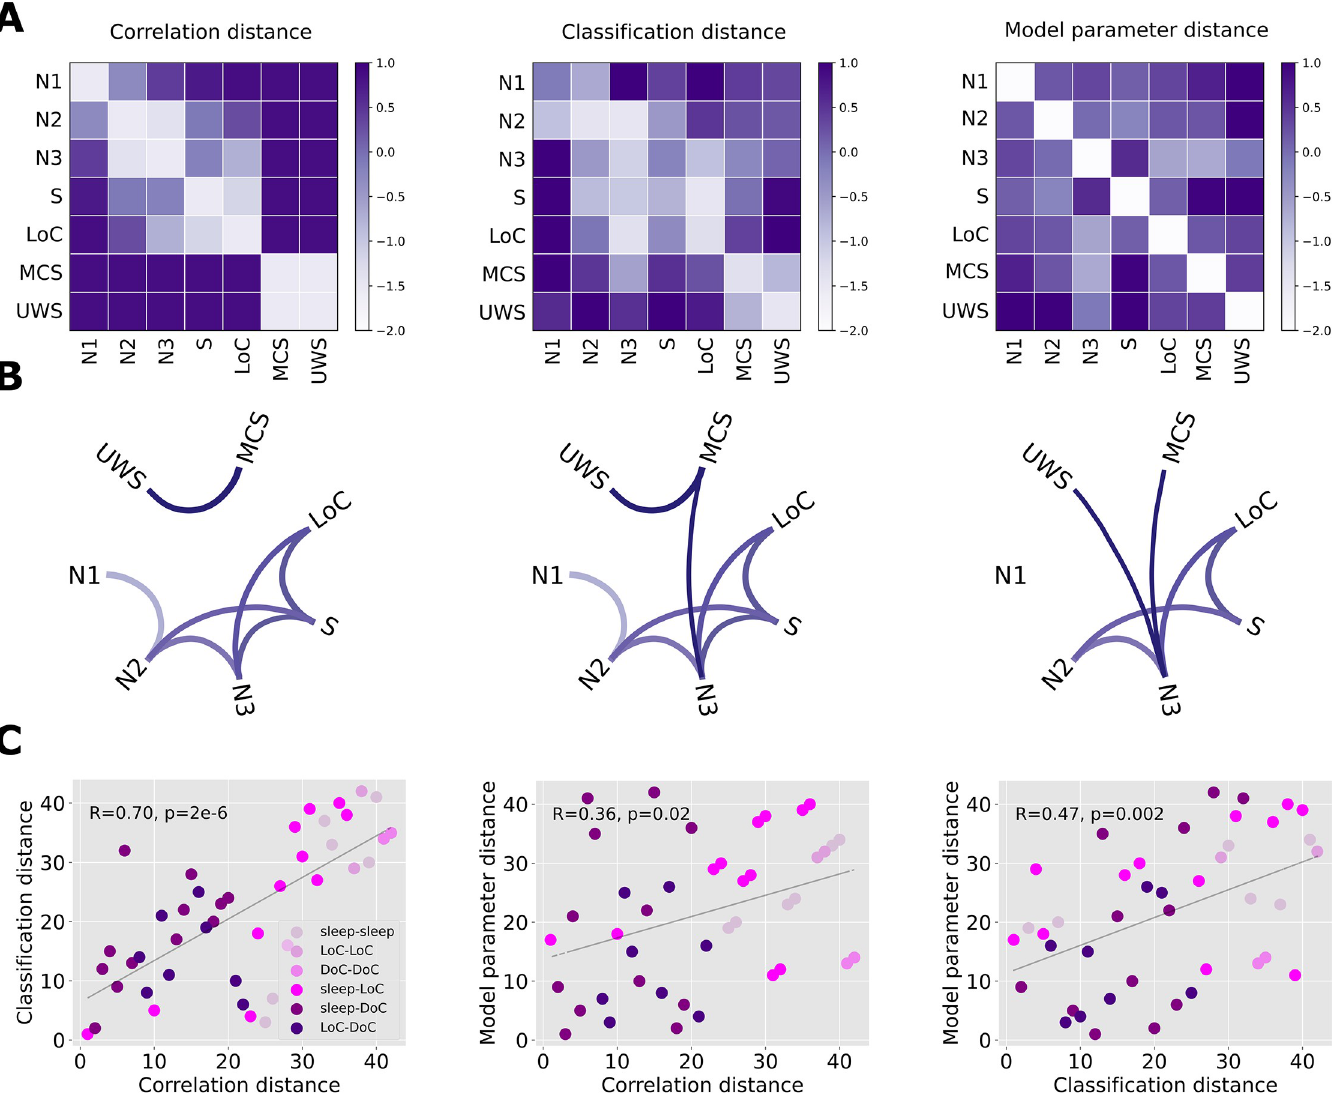
Fig 4. Significant positive correlations between all descriptive distance metrics computed for all pairs of states. (A) Matrices containing z-scores of the correlation, classification and model parameter distances between all pairs of states of consciousness (B) Graph representation of the matrices in panel A, showing only the top 25% matrix elements. (C) Scatterplots establishing the positive and significant correlation between all descriptive distance metrics. Each point represents a pair of states, and the shade of purple indicates one of the following combinations of states: sleep-sleep, LoC-LoC, DoC-DoC, sleep-LoC, sleep-DoC, LoC-DoC. Since variables were converted to ranks prior to the visualization, R and p represent the Spearman’s rank correlation coefficient and its associated p-value, respectively.